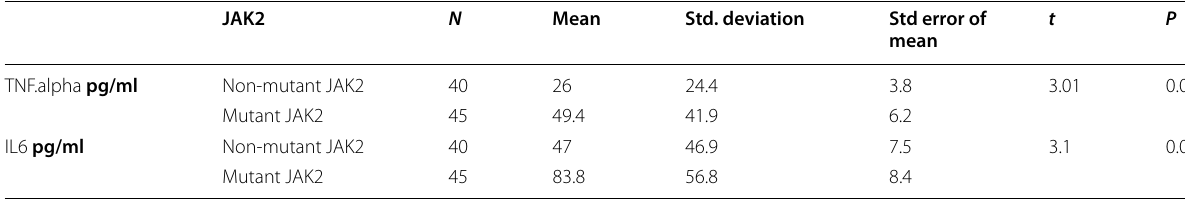
Table 5 Mean serum levels of TNF alpha, IL6 in mutant and non‑mutant JAK2 RA patients JAK2 N Mean Std.